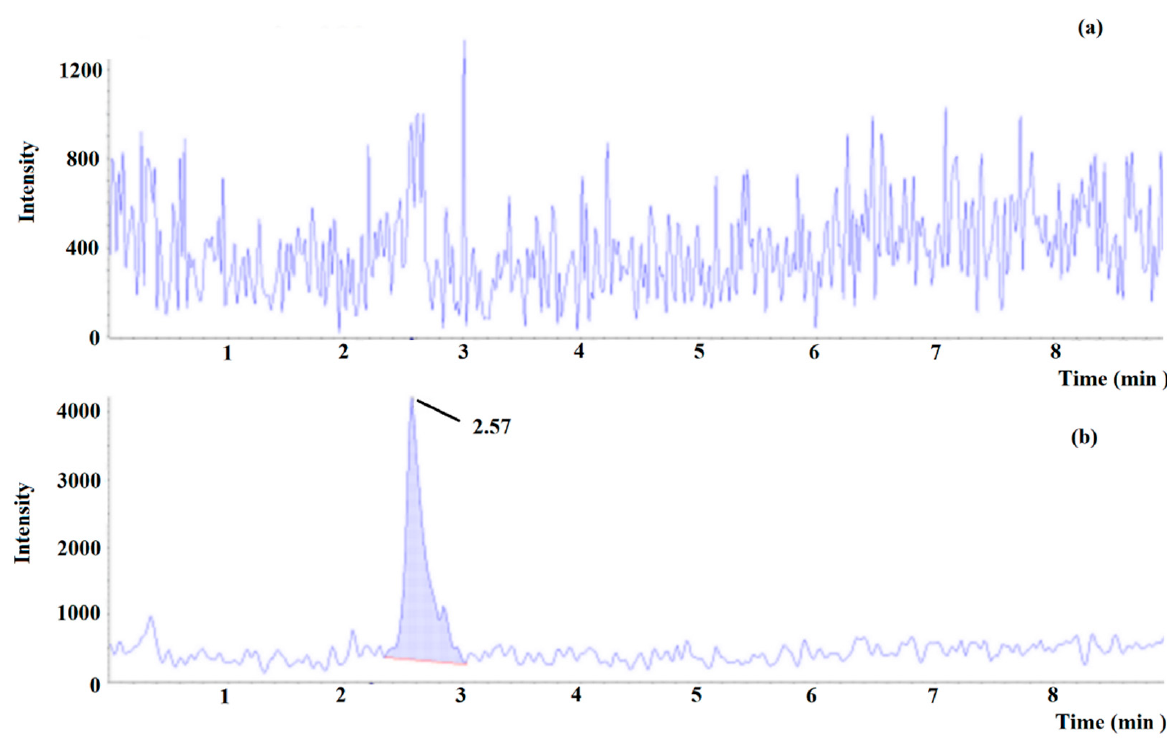
Figure 7. Multiple reaction monitoring (MRM) chromatogram of tyramine in ( a ) blank beer and ( b ) blank beer spiked at lower limit of quantitation (0.15 mg L − 1 ).